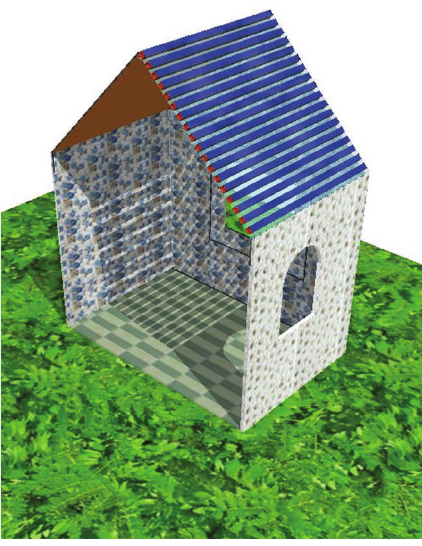
Figure 1: Schematic diagram of the SPV/T with water cooling on a